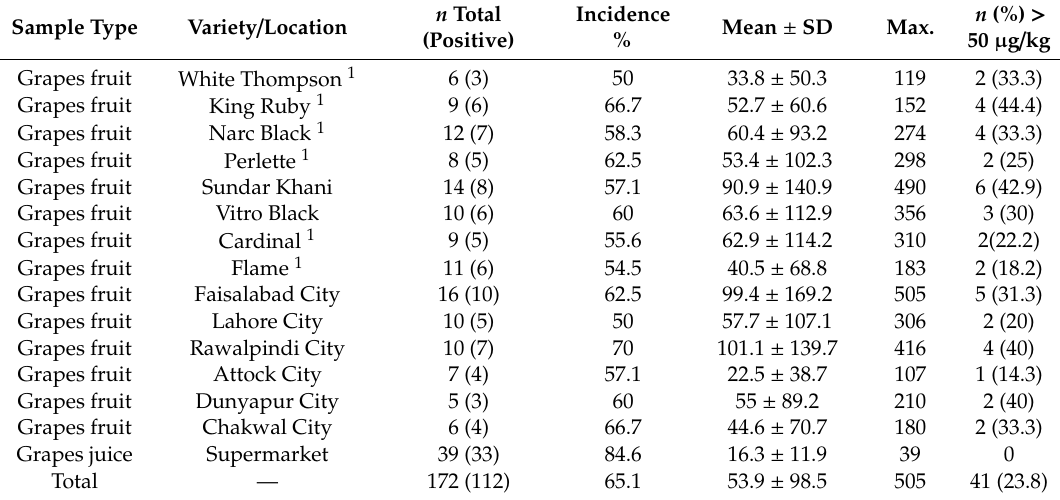
Table 3. Occurrence of patulin ( µ g / kg) in grapes fruits, and their derived